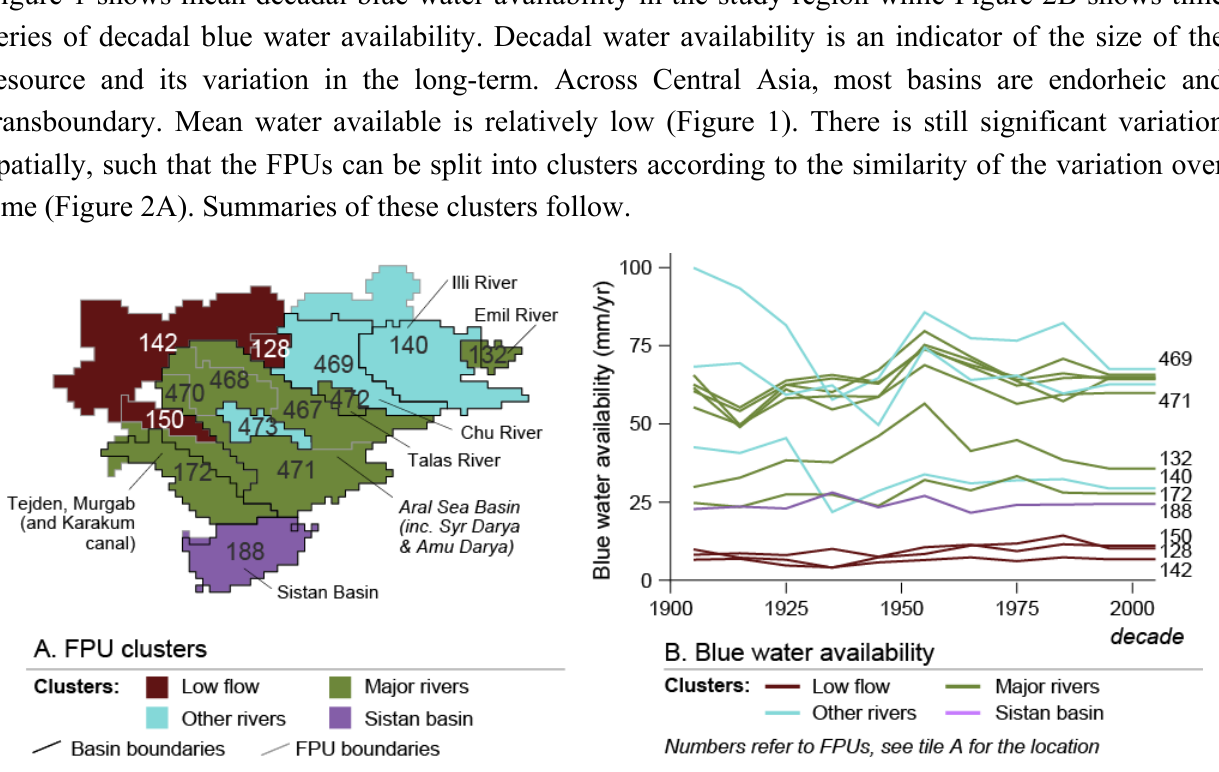
Figure 2. Decadal water availability: ( A ) Map of food production units (FPUs) showing clusters based on correlation of their time series, along with major basins; ( B ) water availability time series for each FPU, colored according to the same